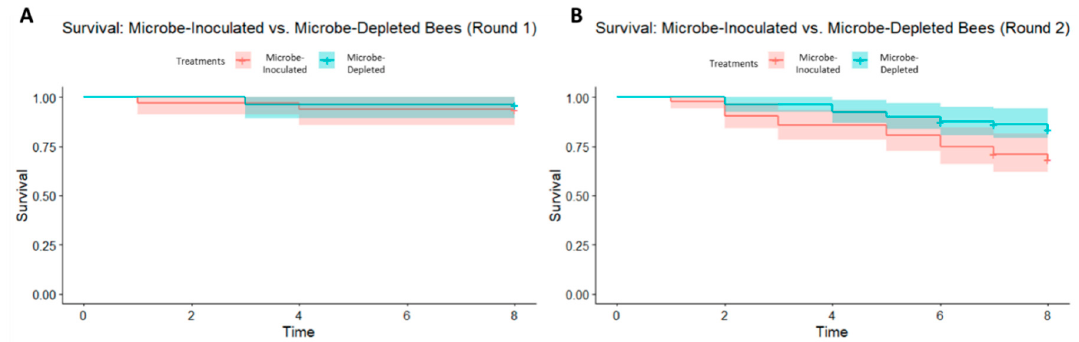
Figure 4. ( A ) Kaplan–Meier curve of bumble bee survival probability from experimental round 1 (Kaplan–Meier log-rank test, chi-squared = 4.3, df = 7, p = 0.7) and ( B ) experimental round 2 (Kaplan–Meier log-rank test, chi-squared = 42.3, df = 9, p < 0.0001) with 95% confidence intervals.